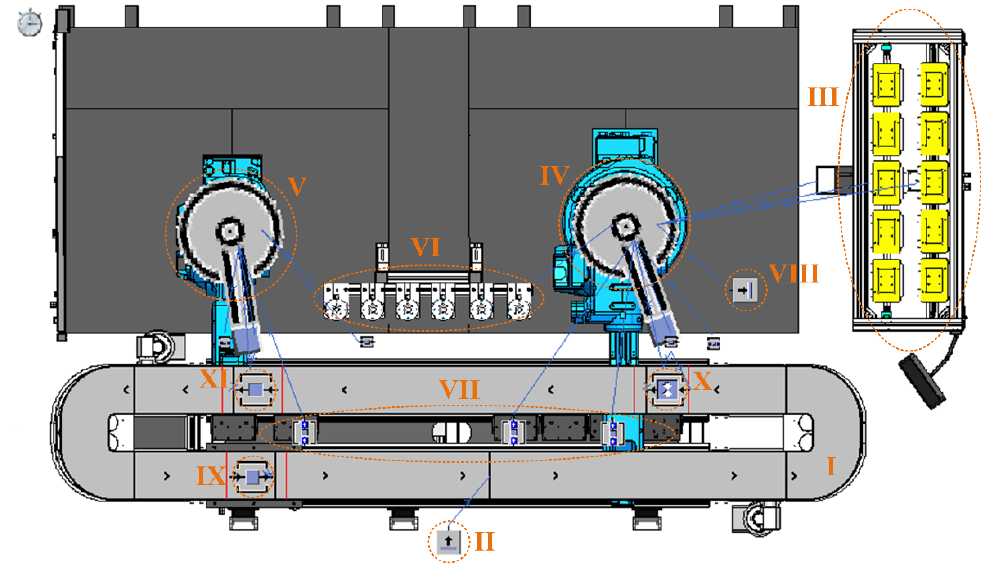
Figure 14. The digital model of the manufacturing system with all the building blocks and connections between them.